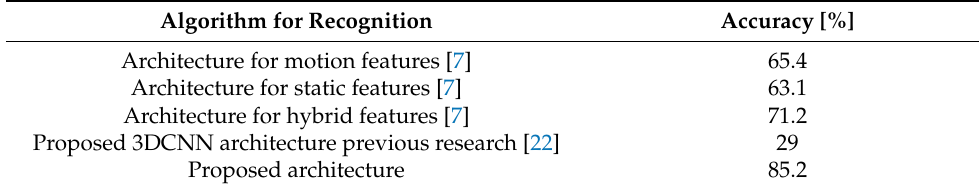
Table 5. Comparison of accuracy obtain by different neural network architectures using UCF YouTube Action